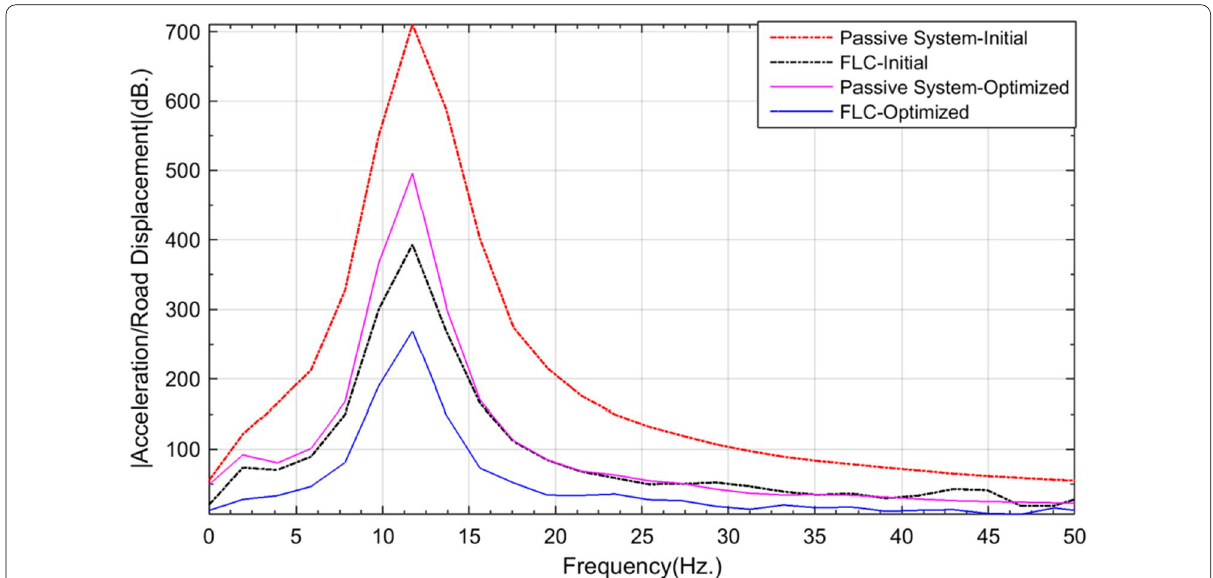
Fig. 11 Frequency domain analysis—passive and FLC suspension system